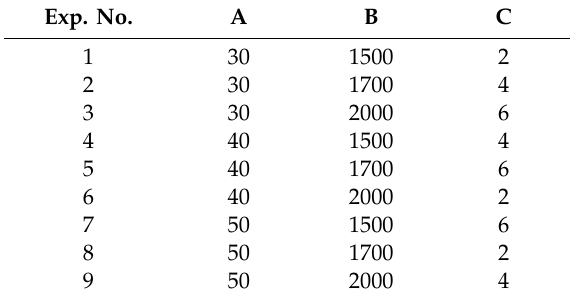
Table 3. Experimentation approach based on the designed experimental log.